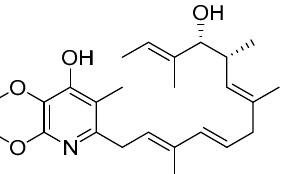
Figure 5. Piericidin A, a natural product T3SS inhibitor isolated from Streptomyces sp. 16–22 [50].